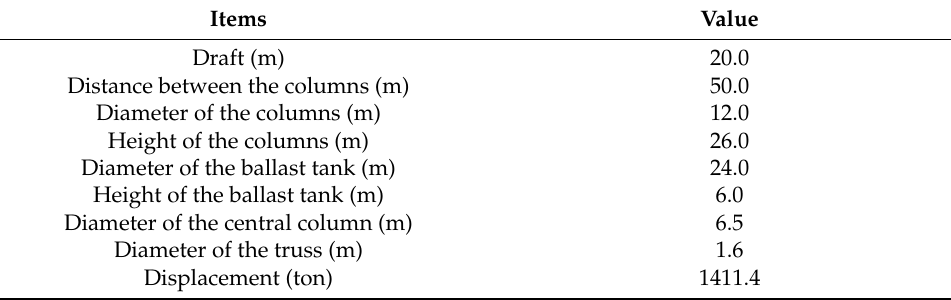
Table 2. Parameters of the DeepCWind floating foundation.